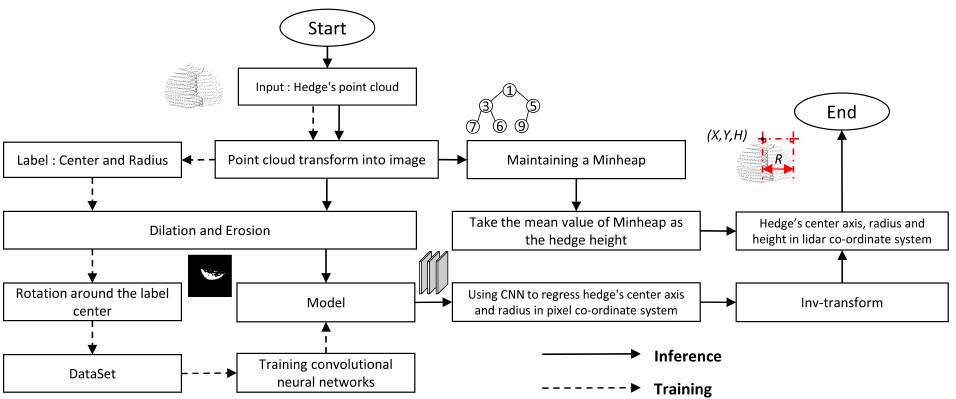
Figure 2. The pipeline of our HeLoDL . The solid arrows represent the inference process, and the dashed arrows represent the training